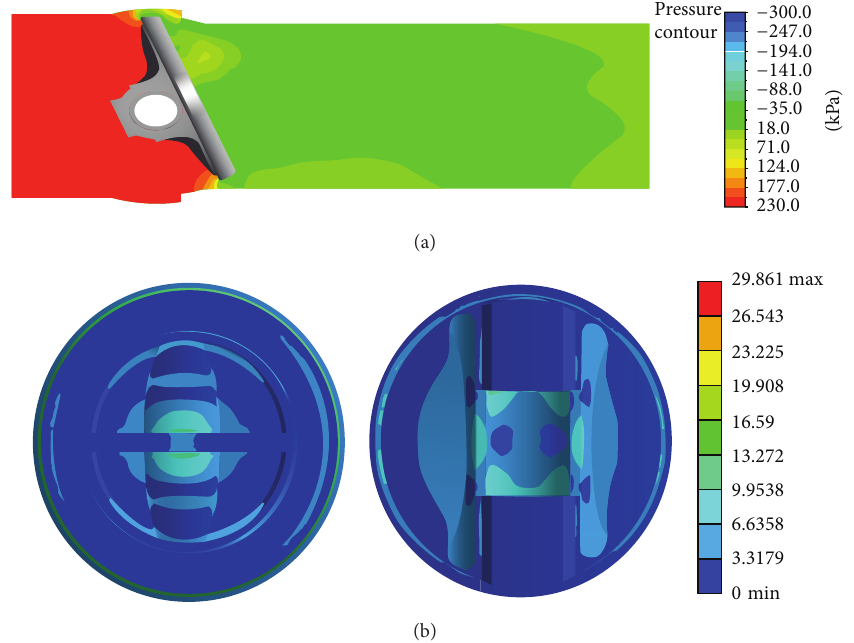
Figure 3: Results of the numerical simulations on the flow and structure of the initial model: (a) pressure distribution around the valve and (b) stress distribution on the valve disc.